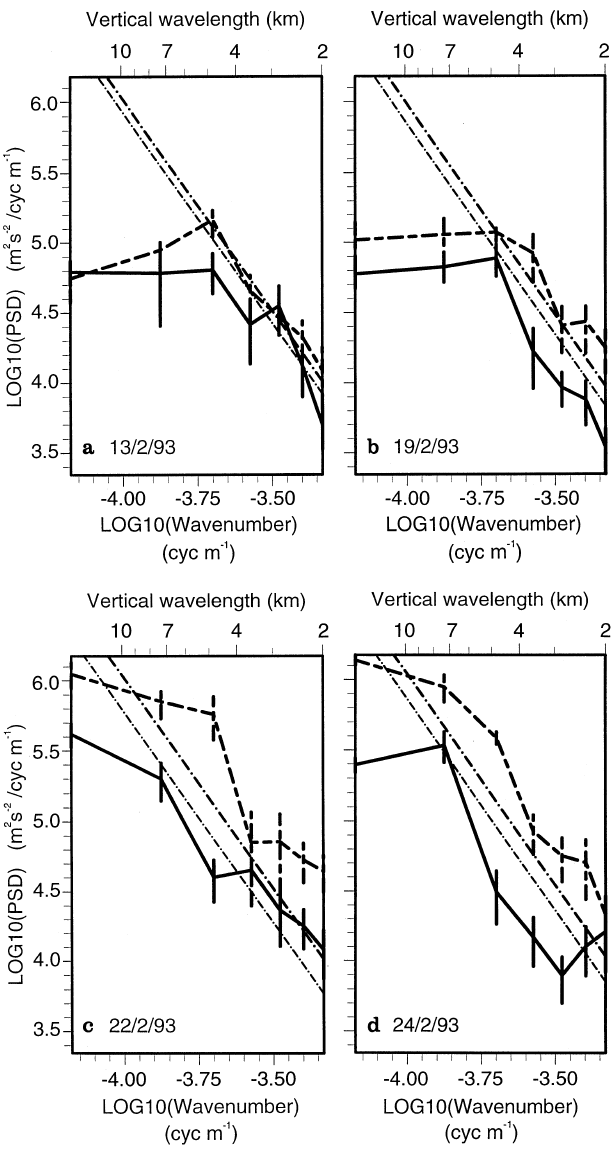
Fig. 7a–d. The mean vertical wavenumber power spectra for 35– 50 km and 50–65 km, represented by full and broken lines , respec- tively, derived from observations on the nights of a 13, b 19, c 22 and d 24 February 1993, the vertical bars representing one standard deviation either side of the mean values. The dot-dash lines represent the saturation power spectral densities, N 2 , the heavy and light lines 10 m 3 referring to the 35–50-km and 50–65-km height